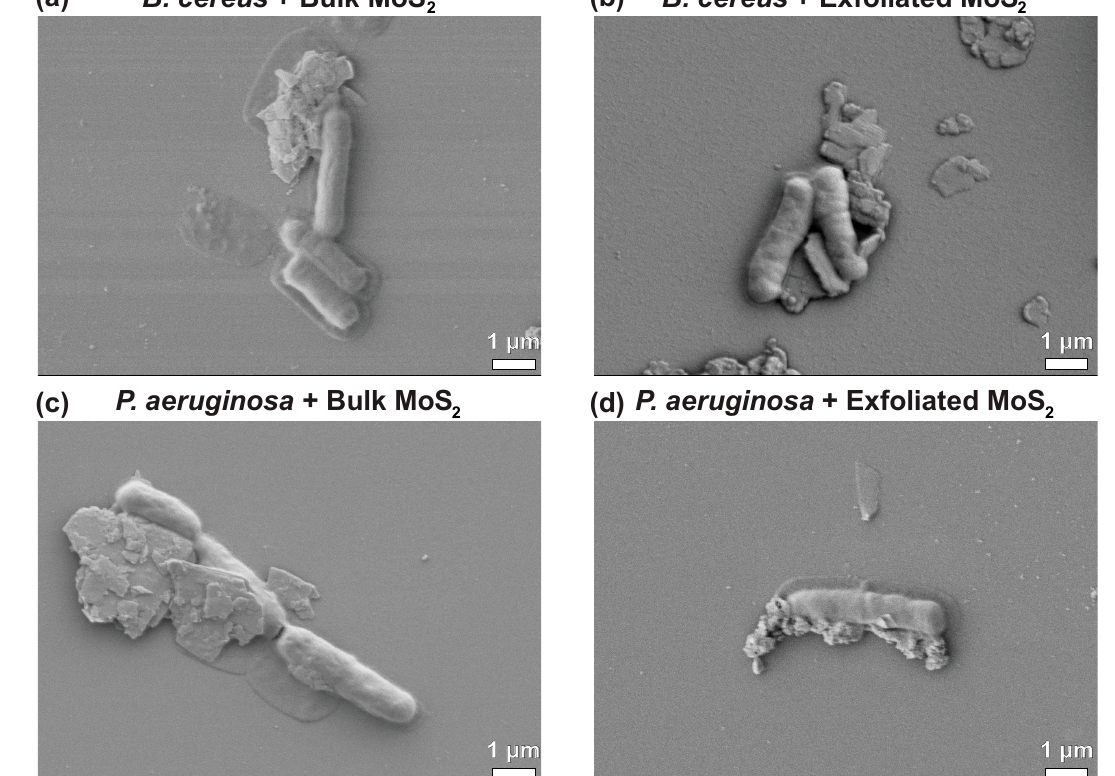
Figure 6. SEM micrographs showing interactions between soil bacteria and MoS 2 particles at a concentration of 4.0 mg/mL for an inoculation time of 12 h. ( a ) B. cereus inoculated with bulk MoS 2 , ( b ) B. cereus inoculated with exfoliated MoS 2 , ( c ) P. aeruginosa inoculated with bulk MoS 2 , and ( d ) P. aeruginosa inoculated with exfoliated MoS 2 . Additional SEM images are shown in Figures S5 and S6, in the Supplementary Materials.